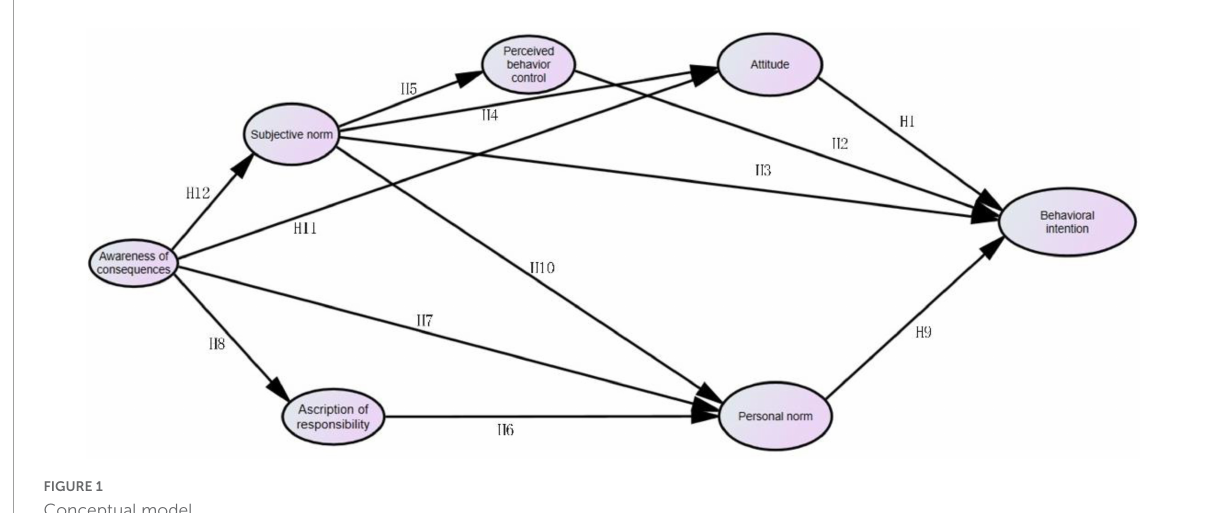
FIGURE1 Conceptual